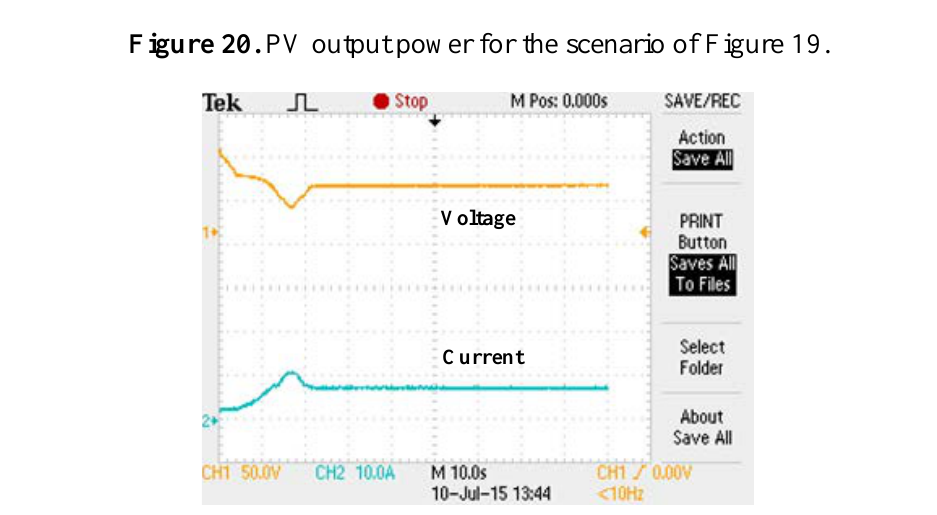
Figure 21. The performance of voltage and current for the scenarios of Figure 19 by implementing the DSMPP